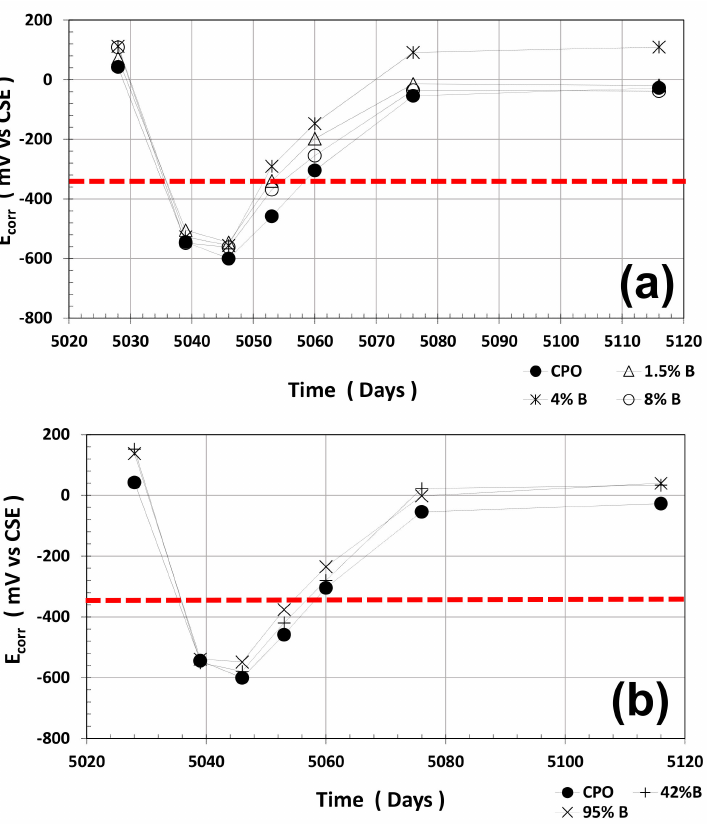
Figure 1. Half-cell potentials (HCPs) vs. time: ( a ) control vs. low Opuntia ficus-indica (OFI) mucilage concentration; ( b ) control vs. high OFI mucilage